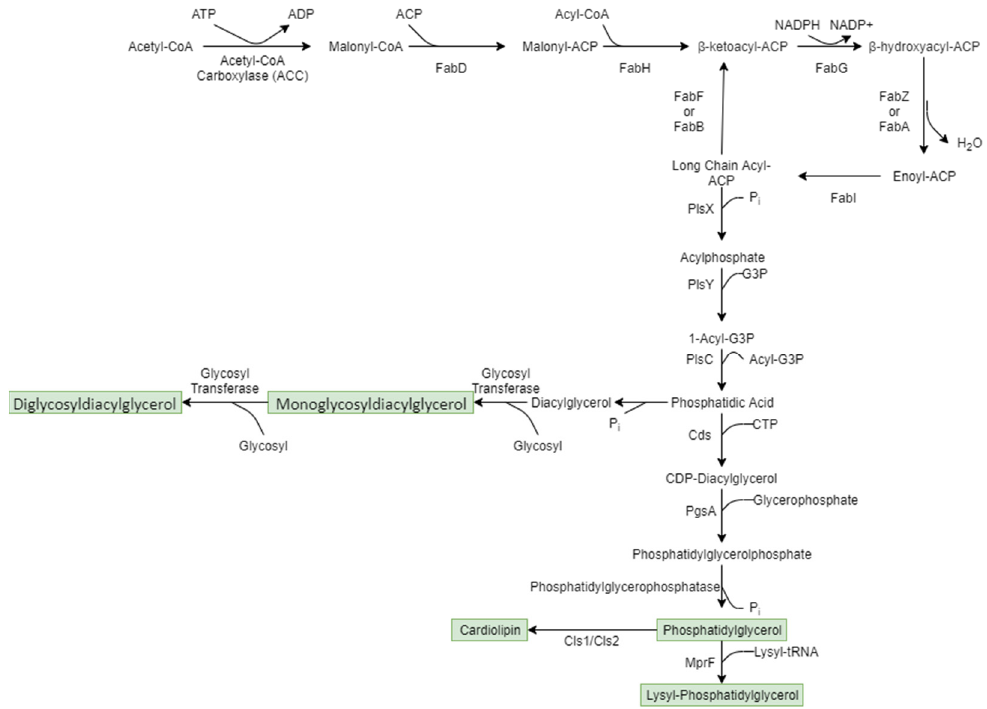
Figure 11. Cell membrane lipid synthesis pathway.